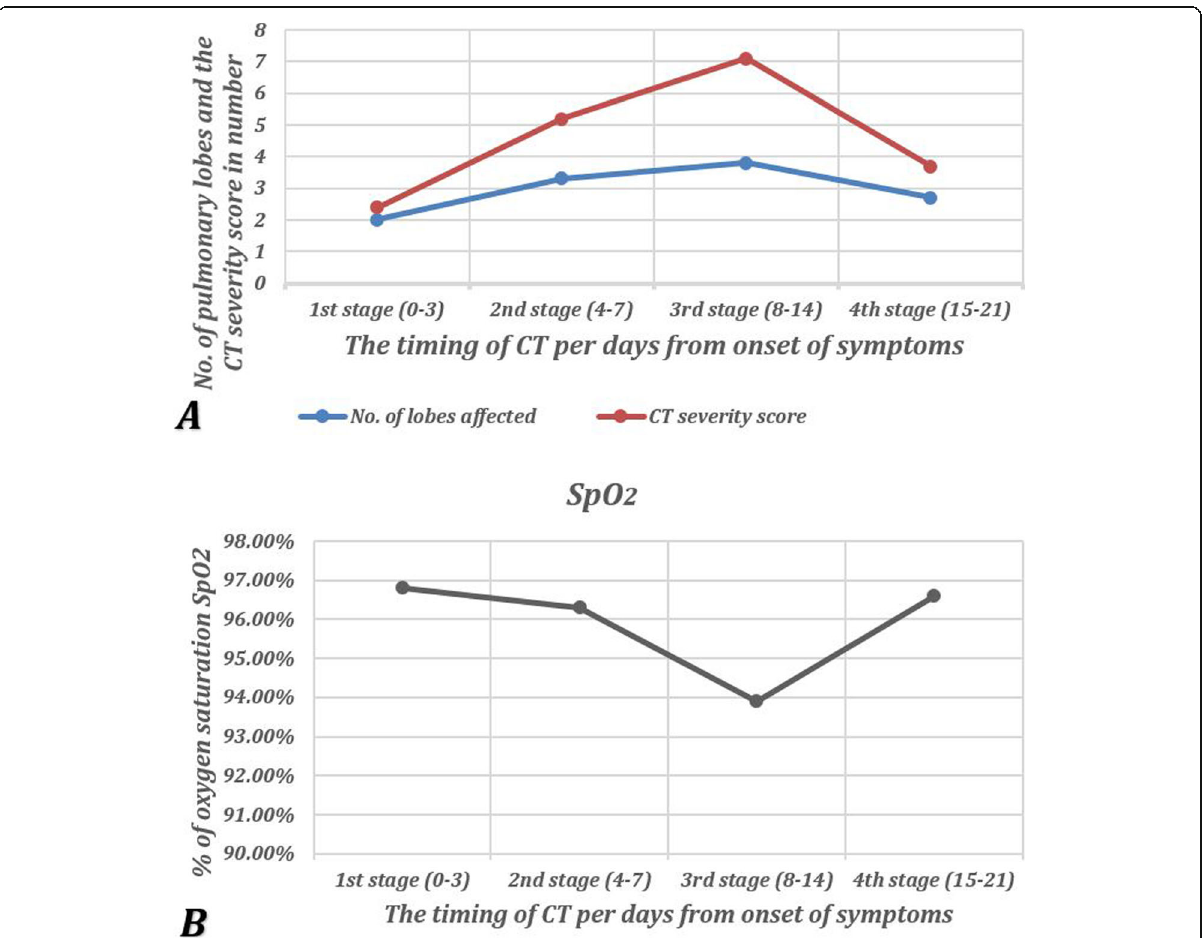
Fig. 5 A diagram shows the changes in the numbers of the lobes affected by COVID-19 and CT severity score ( a ) as well as the oxygen